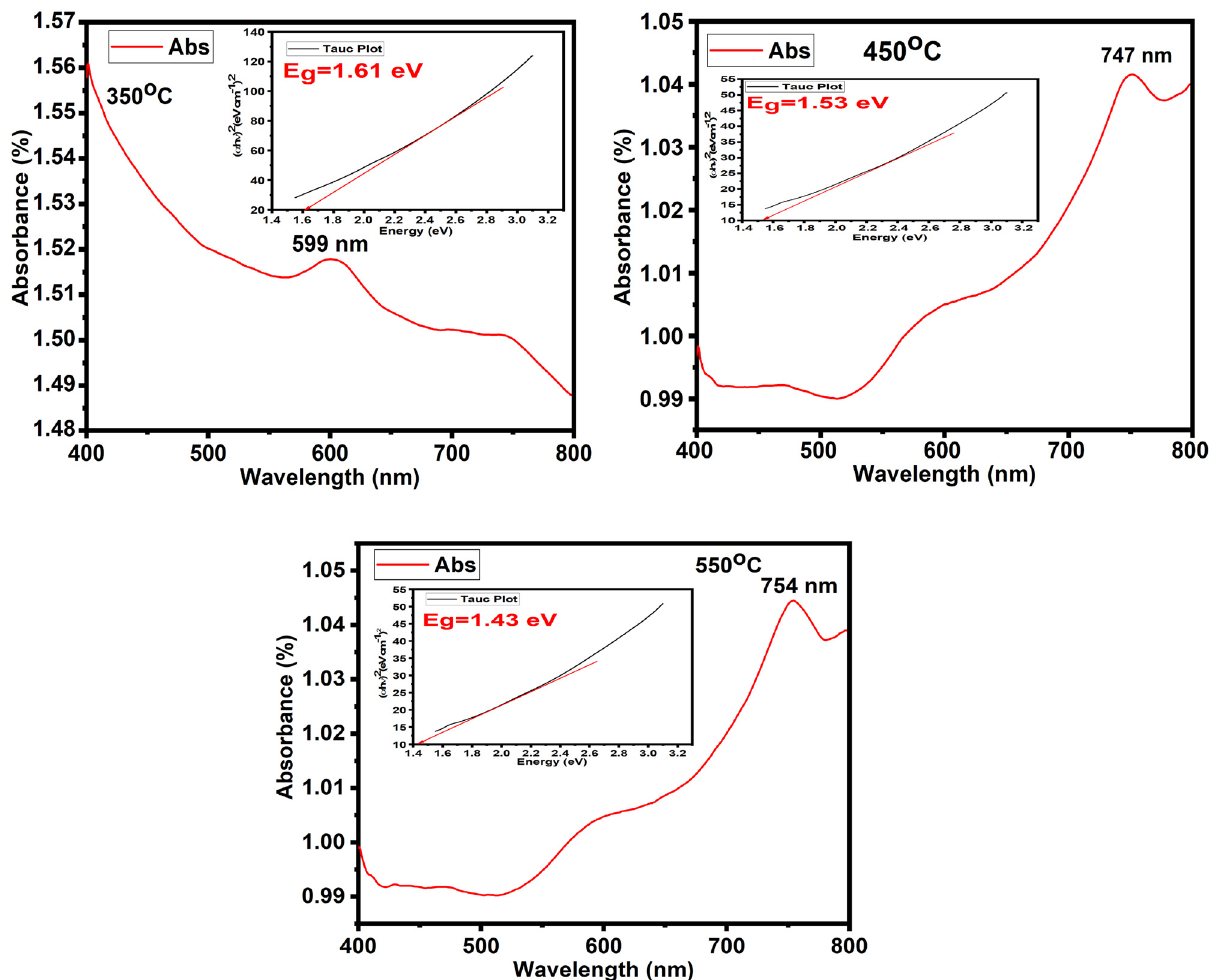
Figure 6: UV absorbance and optical bandgap of CuO samples calcined at 350, 450, and